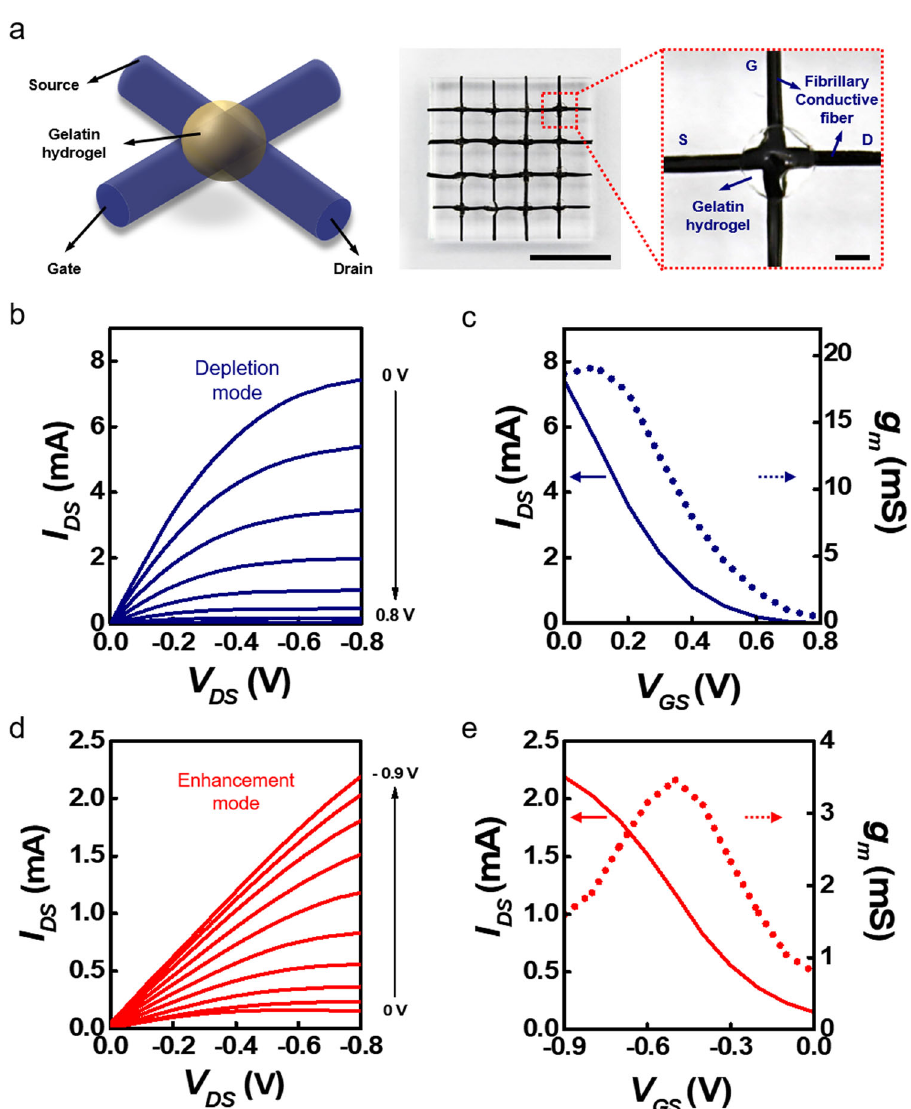
Fig. 4 PEDOT:PSS conductive fi bers based interdigitated organic electrochemical transistors. a Schematic illustration and photographs of PEDOT:PSS conductive gel fi ber-based OECTs (scale bar = 1 cm). b – e Characteristics of organic electrochemical transistors (OECTs) with PEDOT: PSS conductive gel fi ber. (Width of 200 μ m and Length of 2 mm). b Output and c transfer (at V_DS = − 0.6 V) characteristics of PEDOT:PSS conductive gel fi bers based OECTs operated in a depletion-mode. d Output and e transfer (at V_DS = − 0.6 V) characteristics of